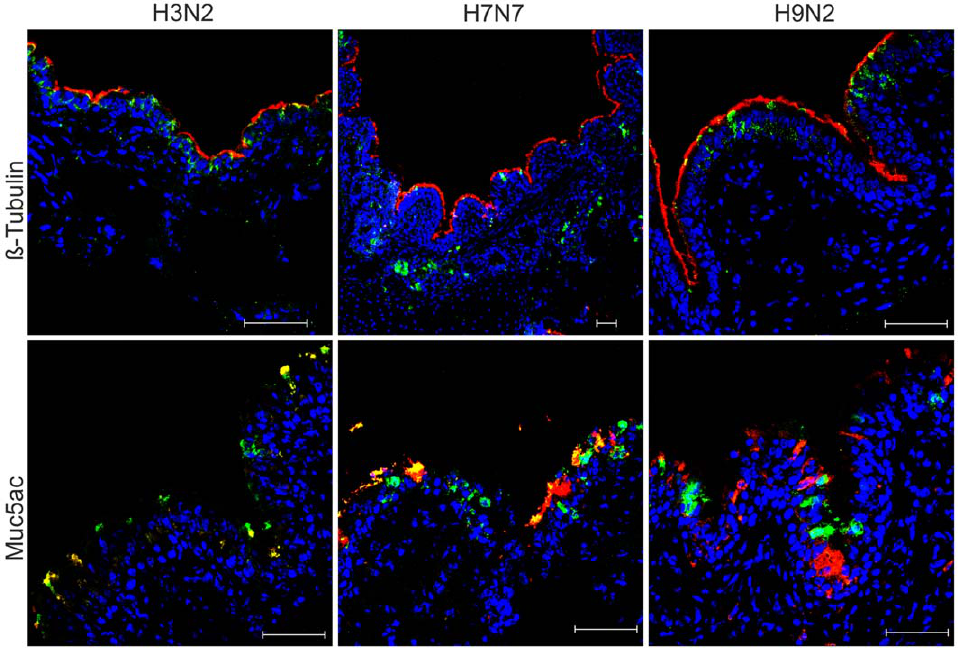
Figure 7. Infection of swine PCLS by influenza viruses characterized by immunostaining. PCLS were infected by either porcine H3N2, avian H9N2, or avian H7N7 virus. Cryosections were prepared at 24 h.p.i. and used for detection of infected cells, ciliated cells, and mucus-producing cells. Infected cells were stained with an anti-nucleoprotein antibody (green); ciliated cells were stained using an anti- b -tubulin antibody (red) and mucus-producing cells were stained using an Muc5Ac antibody